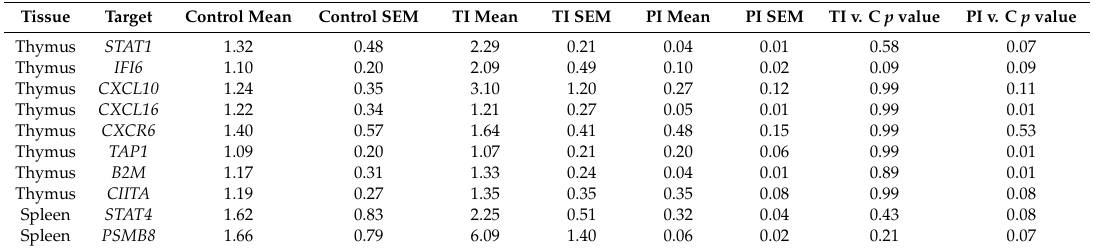
Table A1. Table of genes and their expression in respective tissues. These genes were not measured in both tissues, only one